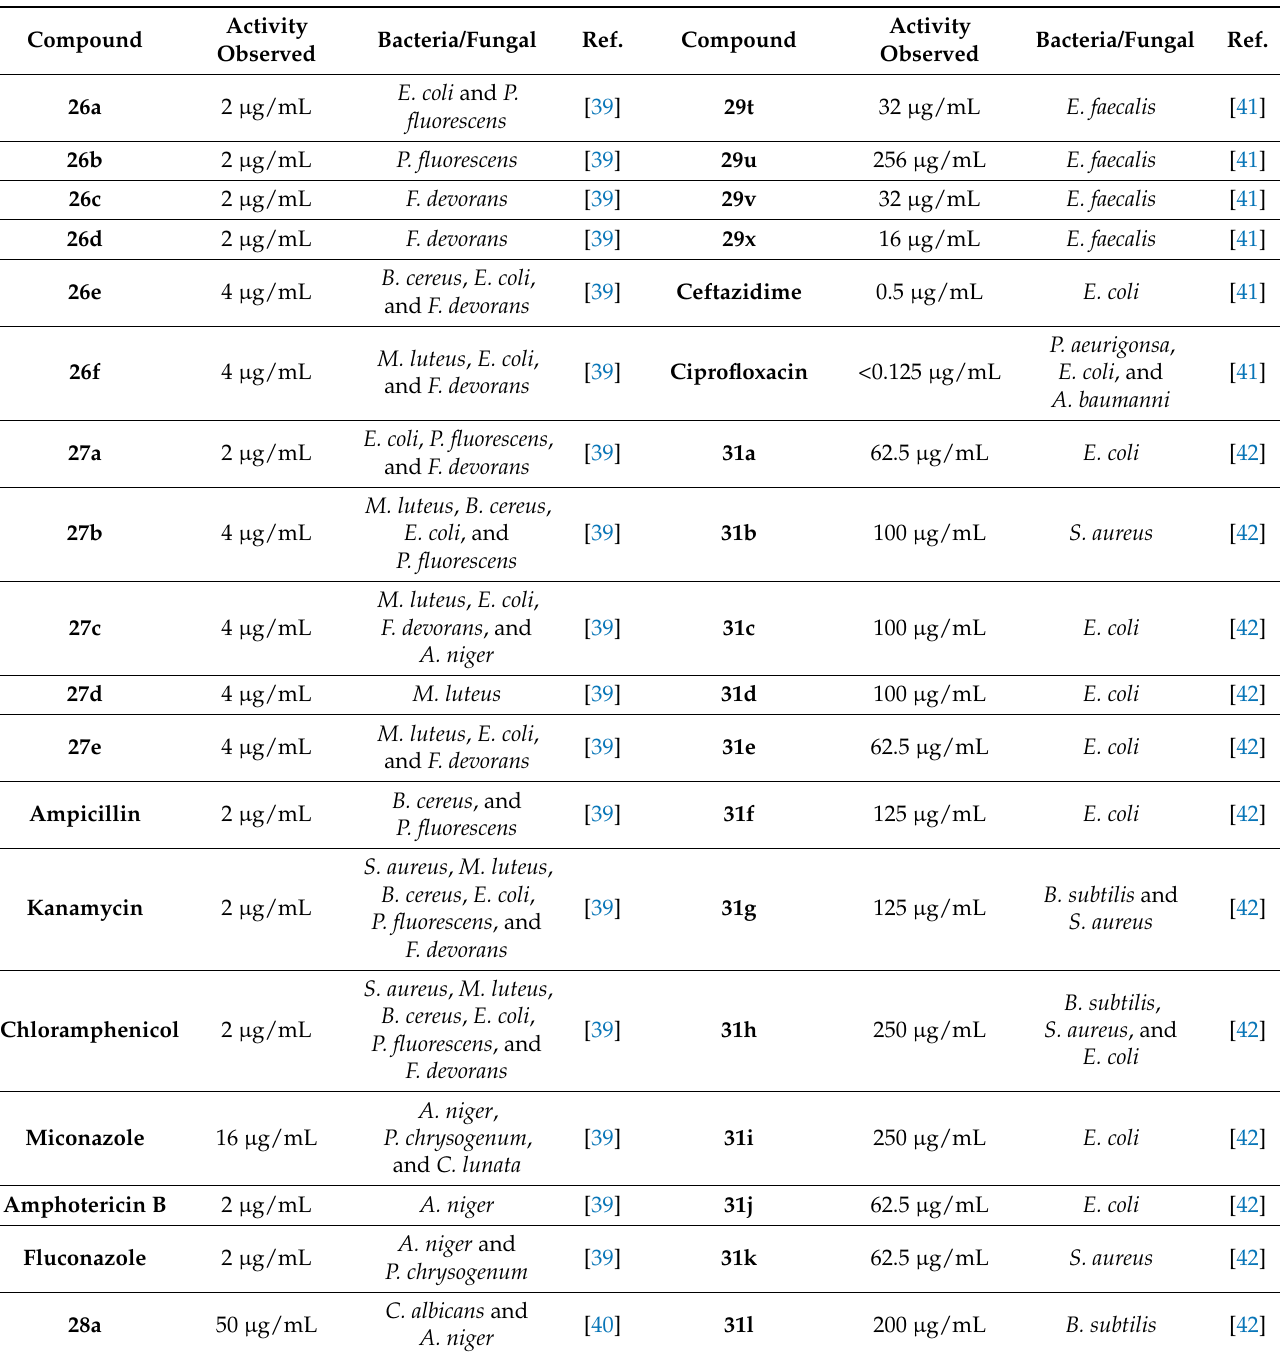
Table 3. Antimicrobial activity data of reported coumarin triazole